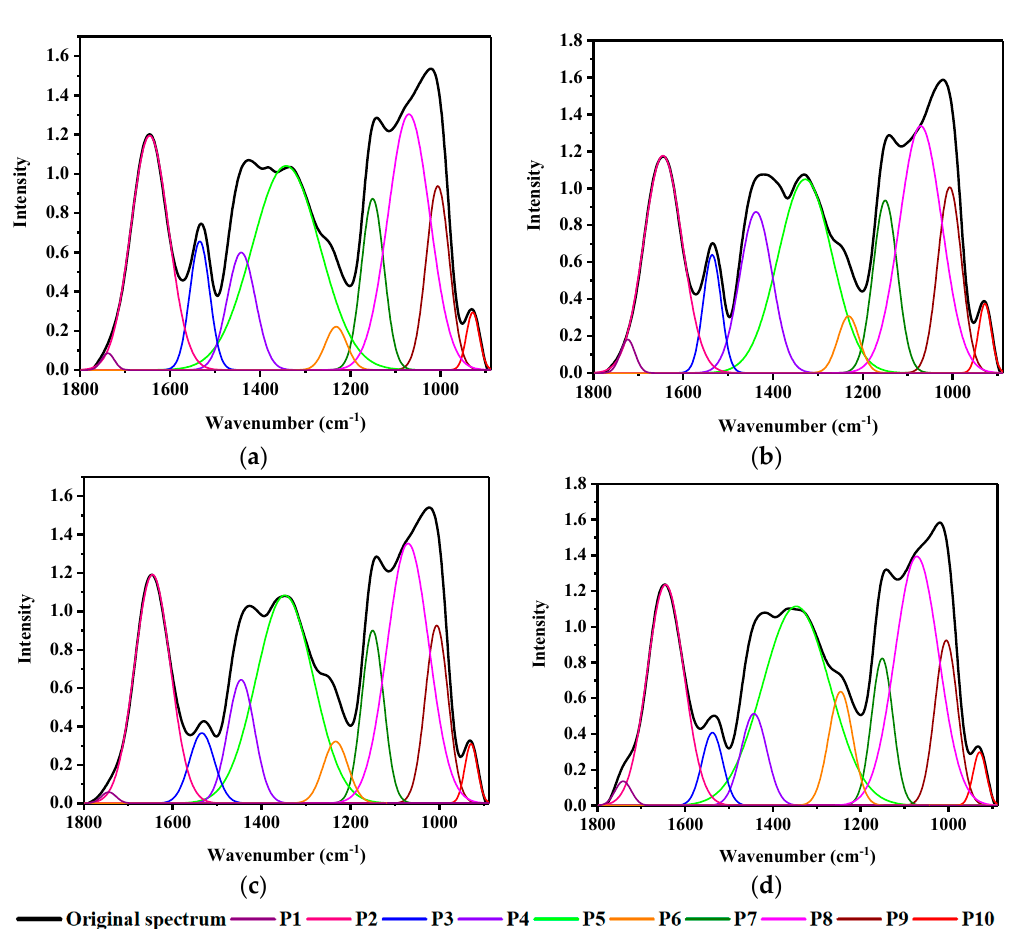
Figure 6. Deconvolution curve-fitting with four different treatments. ( a ) aCaT: ambient CO 2 and temperature; ( b ) aCeT: ambient CO 2 and elevated temperature; ( c ) eCaT: elevated CO 2 and ambient temperature; ( d ) eCeT: elevated CO 2 and temperature.